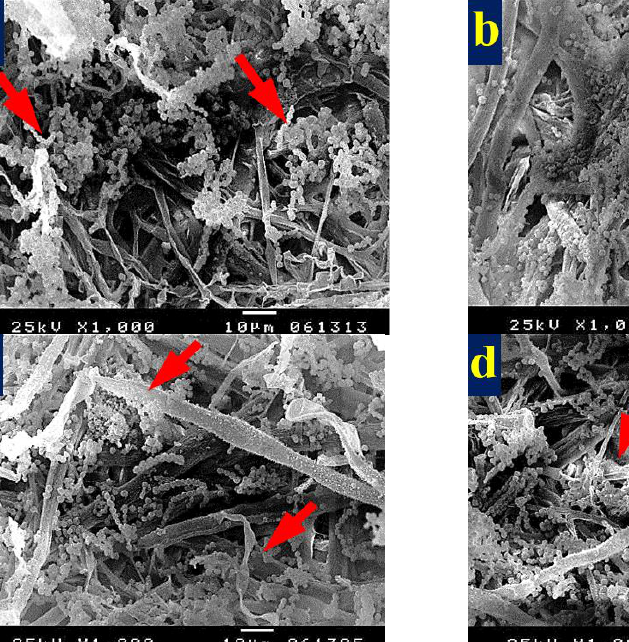
Figure 7. SEM images of M. sinclairii WB pulp paper manufactured with/without HeOE additives and inoculated with A. terreus : ( a ) without HeOE additives; ( b ) with 10% DMSO; arrows in ( a , b ) indicate the prevalence and penetration of fungal mycelia and spores in the sample fibers; ( c,d ) with M. azedarach HeOE at 1%; ( e ) with S. alba HeOE at 1%; ( f ) with M. grandiflora HeOE at 1%, where arrows in ( c – f ) indicate the fungal spores that cover most of the sample fibers and a lower prevalence of the fungal mycelia.